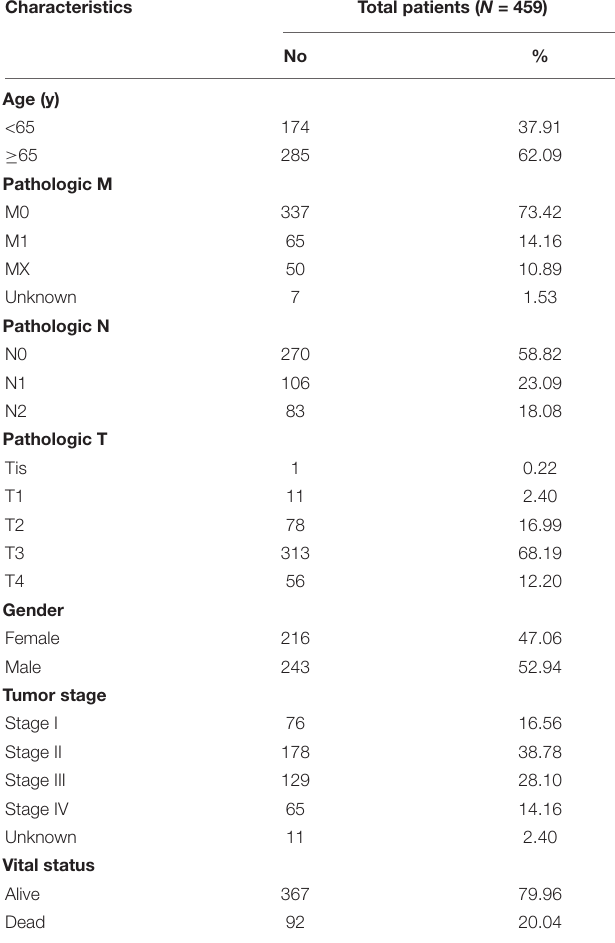
TABLE 1 | Clinical characteristics of COAD patients in the TCGA